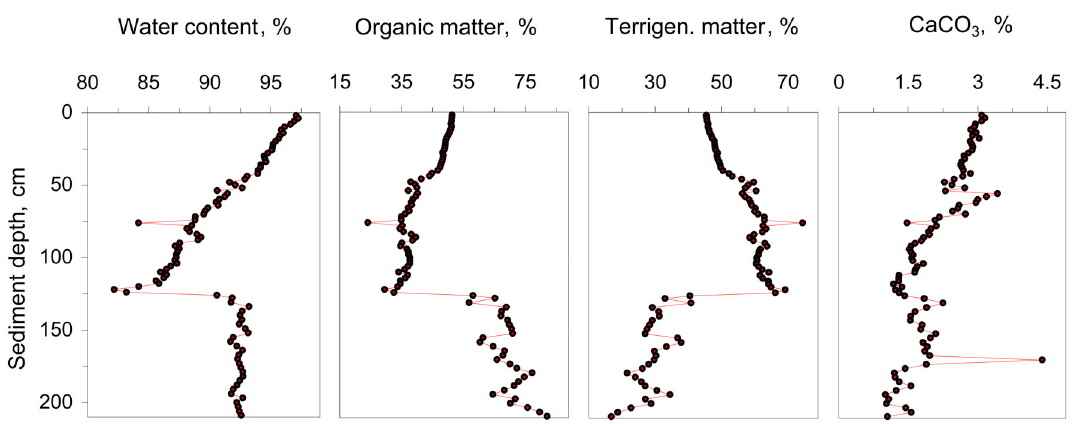
Fig. 2. Depth profiles of major sediment constituents of Lake Kooraste Kıverj(cid:228)rv. Water content is given as percentage of fresh sediment; organic, terrigenous and CaCO 3 matters are expressed as percentages of dried sediment weight.